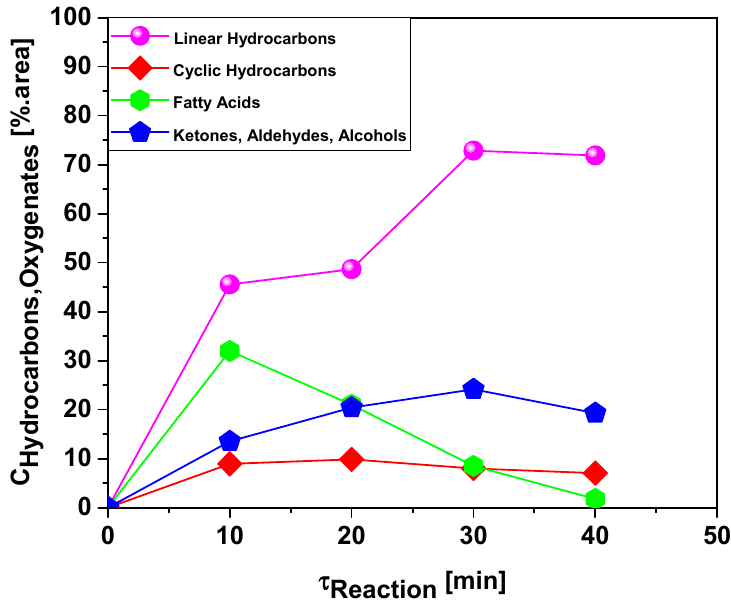
Figure 16. Effect of reaction time on chemical functions presented by the bio-oil obtained through thermal cracking of residual fat.